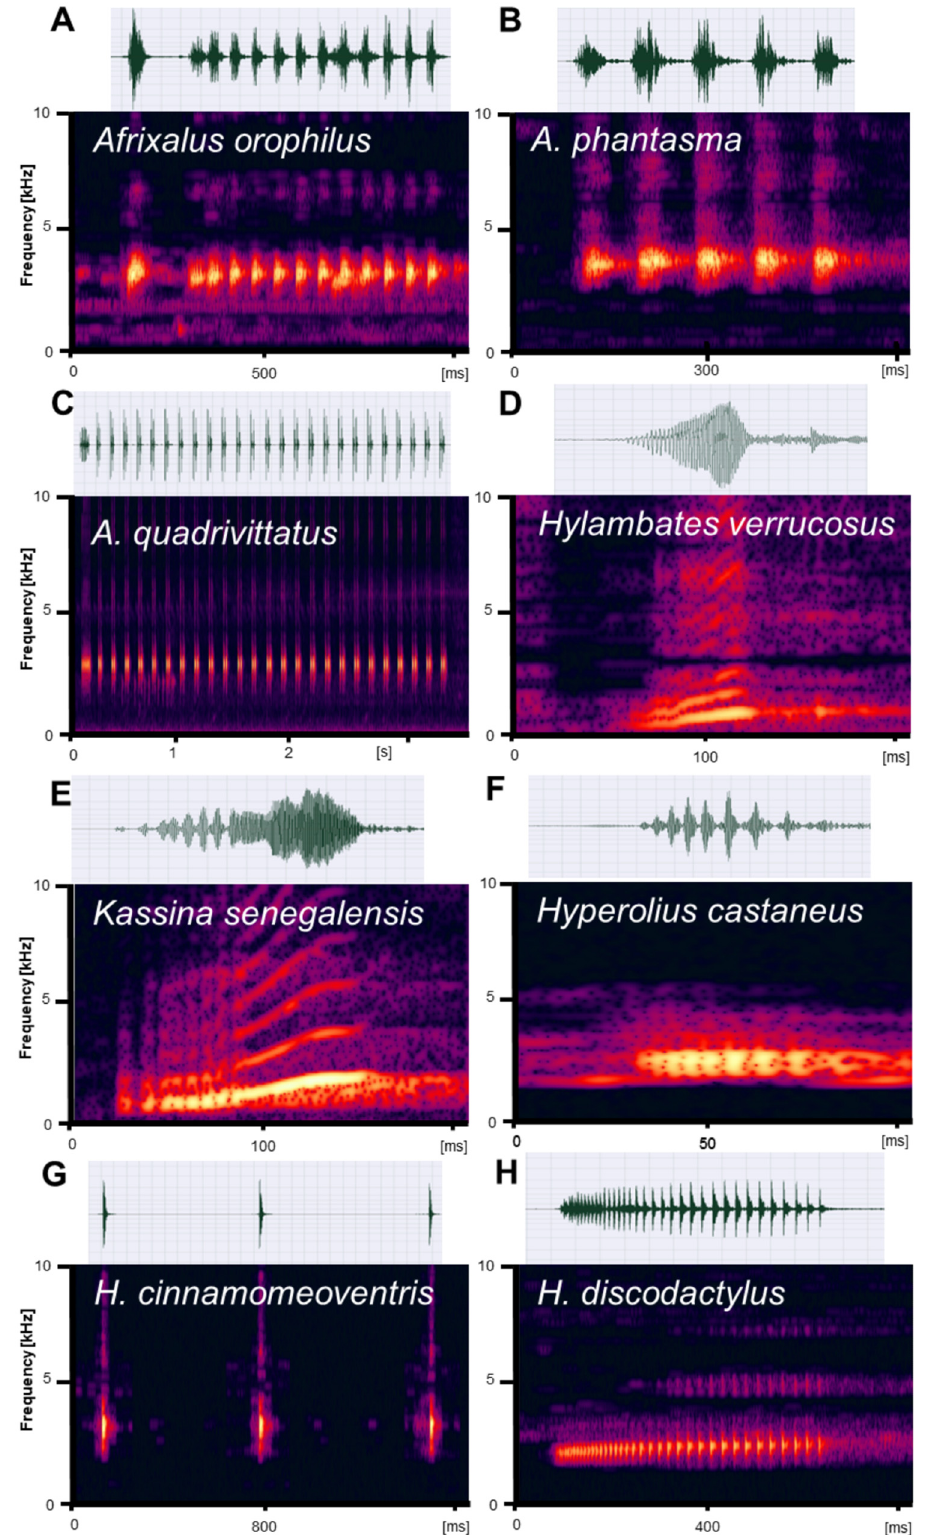
Figure 7. Advertisement calls of Hyperoliidae in Rwanda, I. ( A ) Afrixalus orophilus , ( B ) Afrixalus phantasma , ( C ) Afrixalus quadrivittatus , ( D ) Hylambates verrucosus , ( E ) Kassina senegalenis , ( F ) Hyper- olius castaneus , ( G ) Hyperolius cinnamomeoventris , ( H ) Hyperolius discodactylus . Calls are shown as representative spectrograms and